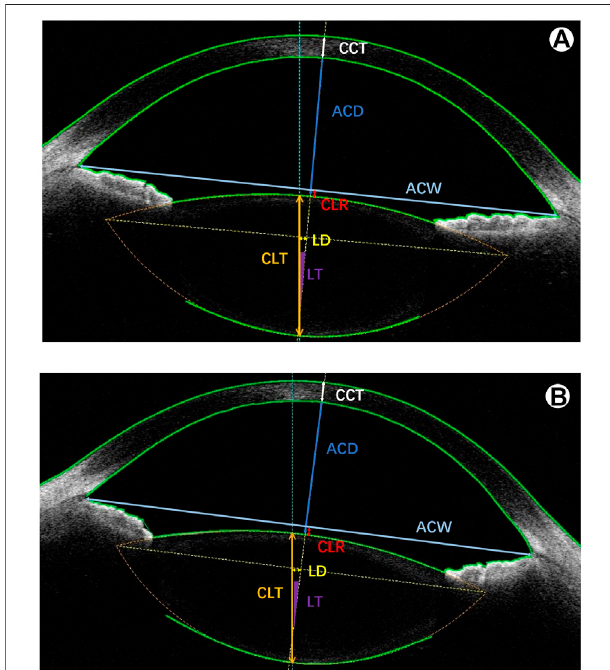
FIGURE1| Arepresentative image withanteriorsegmentparameters of the CASIA2. (A) beforecycloplegia; (B) after cycloplegia. CCT: central corneal thickness;ACD:anteriorchamberdepth;ACW: anteriorchamber width;CLR: crystalline lens rise; CLT: crystalline lens thickness; LD: lens decentration; LT: lens